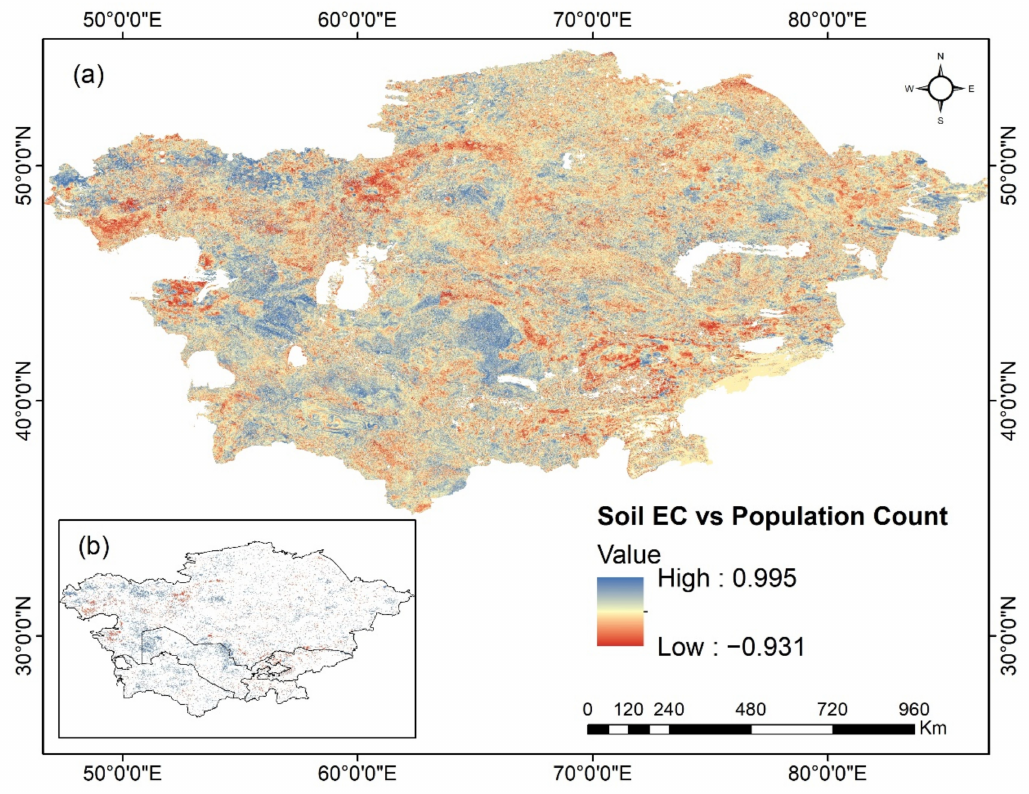
Figure 8. ( a ) Soil EC correlation to population count, and ( b ) significant changes during